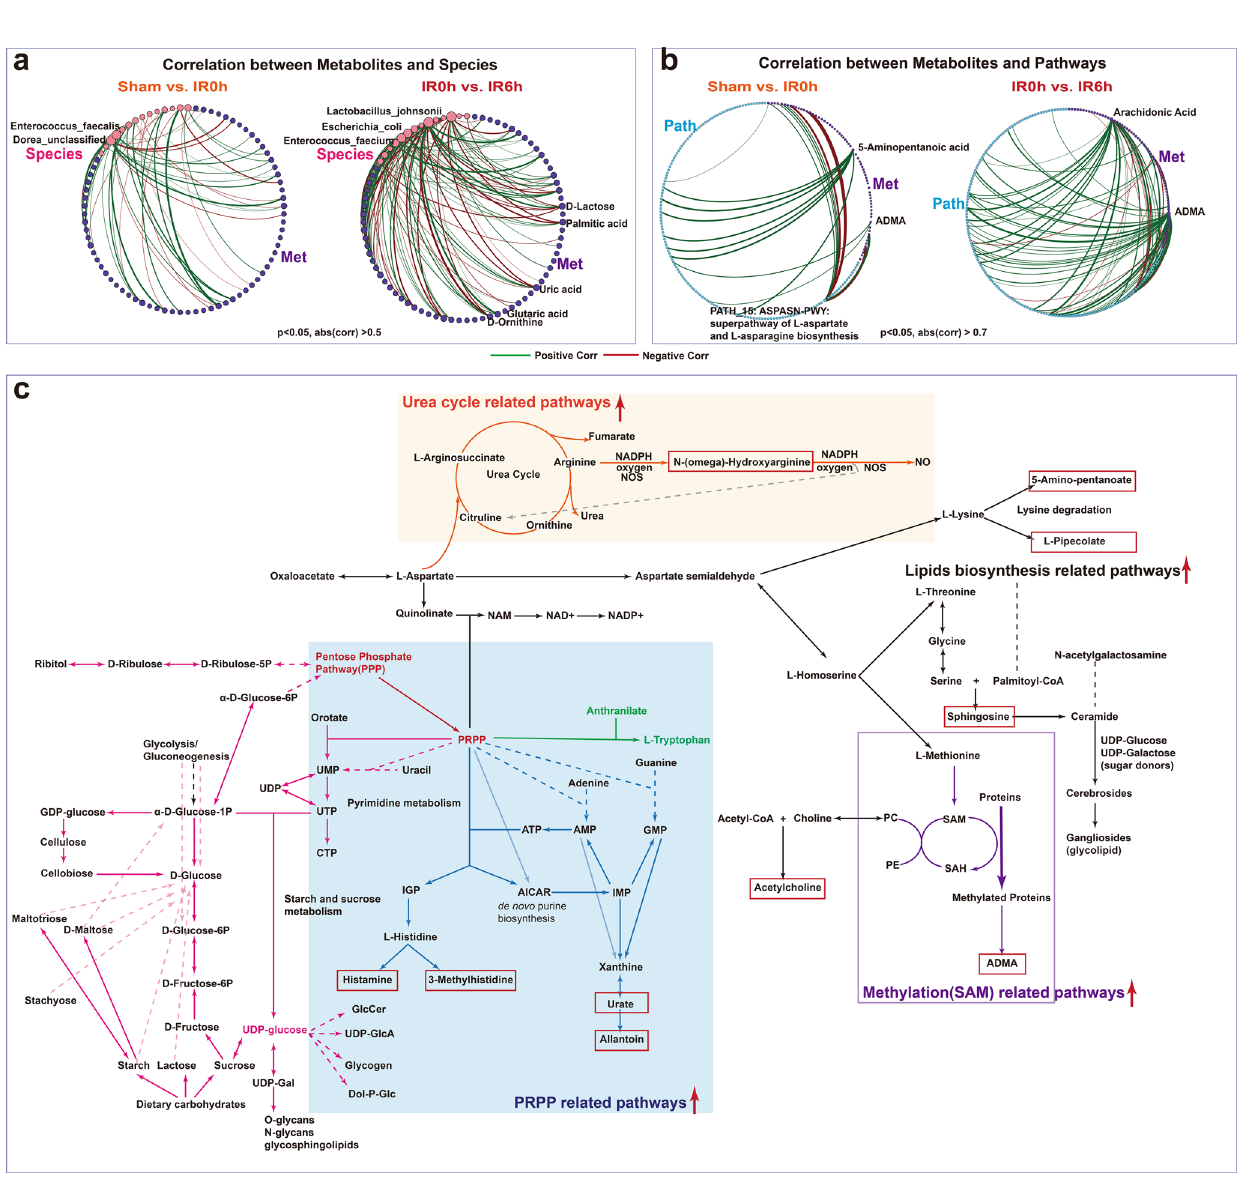
Fig. 6 Integrated microbiome-metabolome analysis identi fi ed key metabolic pathways and underlying key species. a , b Signi fi cantly more connections (Spearman correlations) were identi fi ed between microbial metabolites and species abundance as well as gut pathways during the reperfusion period than that in the ischemia period. c A global map linking signi fi cantly altered metabolites and pathways and their putative underlying key species. Metabolites in the red boxes were those sharply increased at IR6h compared to Sham. Red arrows indicated that the associated pathways were signi fi cantly increased at IIR6h compared to Sham and